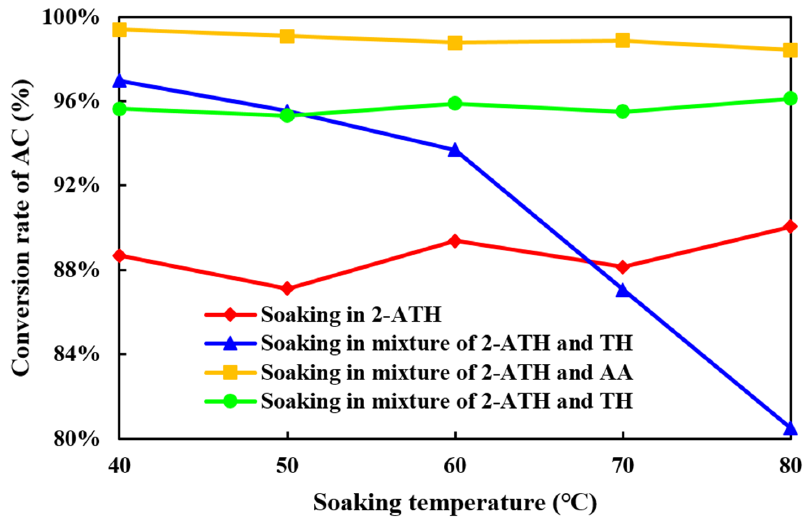
Figure 2. The influence of soaking temperature on the inactivation of H β molecular sieve.